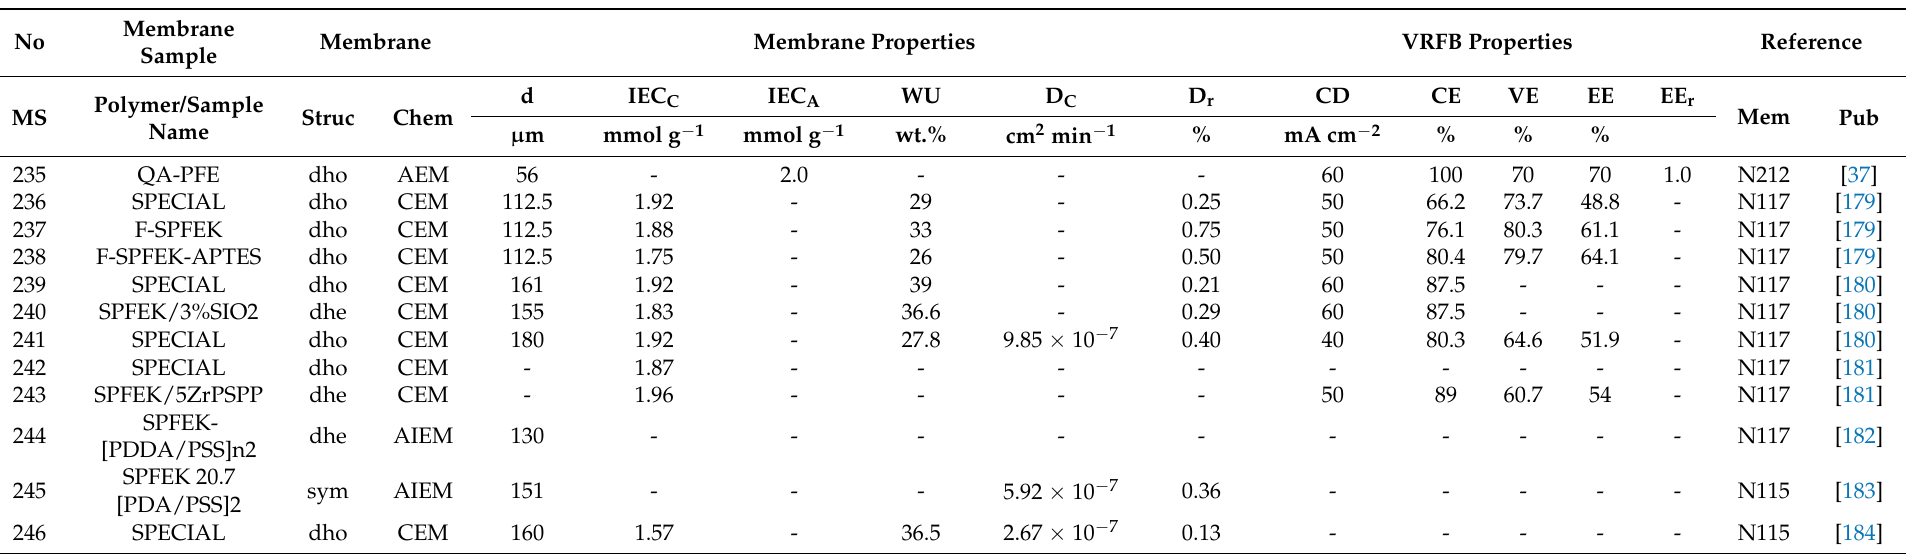
Table 9. List of fluorenyl-ether-based hydro-carbon membrane